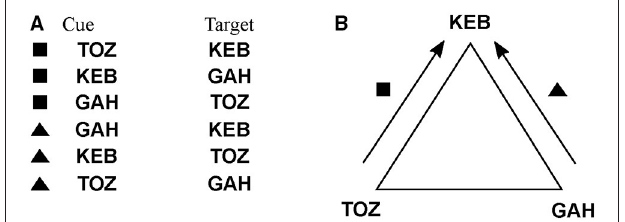
FIGURE 4 | An example cue-target prediction task for a schema induction paradigm showing (A) six cue-target pairs and (B) their geometric interpretation, where trigrams correspond to vertices of a triangle and shapes correspond to clockwise and anticlockwise